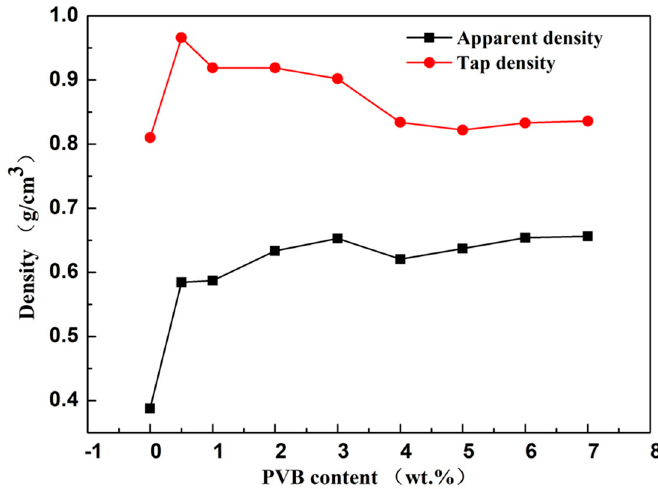
Figure 5. The apparent density and tap density of SiC/PVB composite powders with different PVB contents.